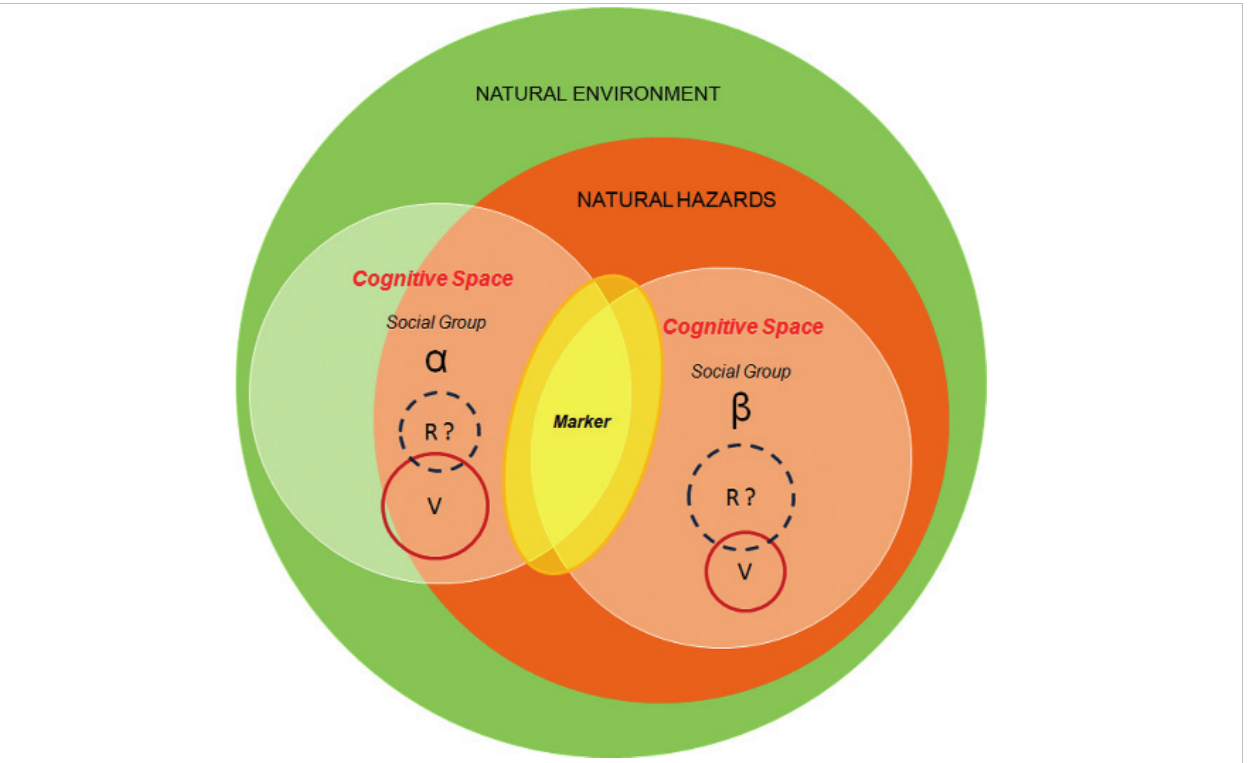
Figure 2. The Coping Capacities Theoretical Model, elaborated by Pannaccione Apa in 2011, suggests that resilient responses could not always directly proportional to level of exposure to risk and distance from a hazard